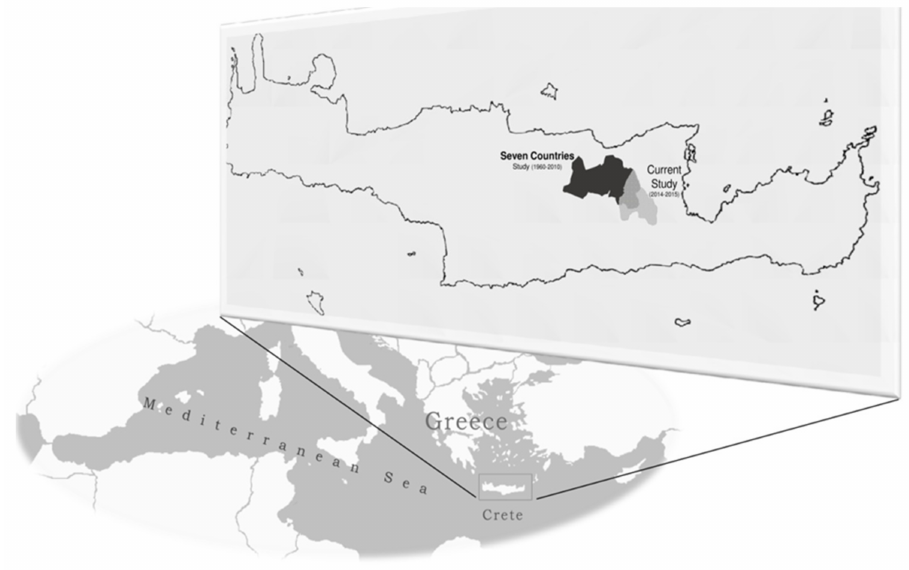
Figure 2. Sampling areas of the current study (MINOA) and the 1960 Cretan cohort of the historical Seven Countries Study (SCS)